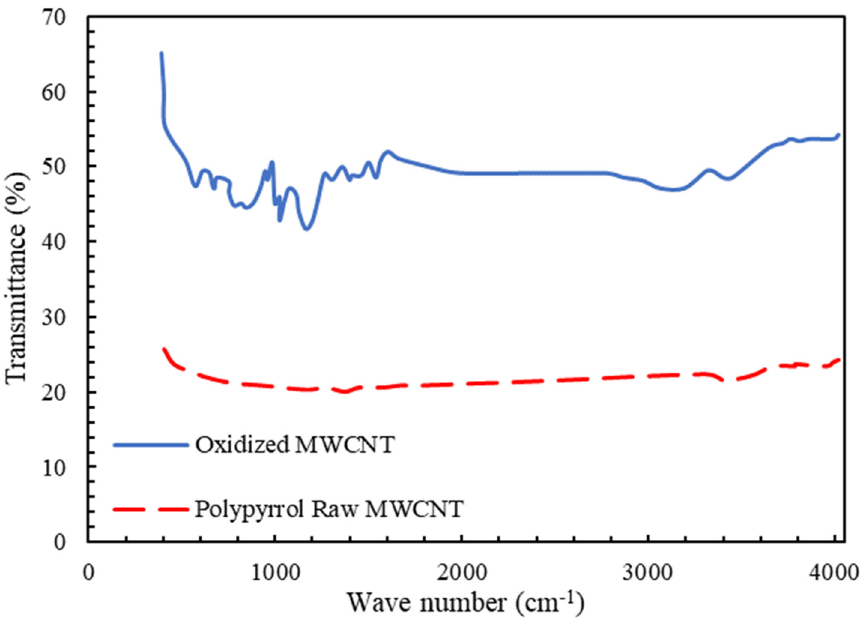
Figure 3. FTIR spectra for determination of compounds on multiwalled carbon nanotubes.